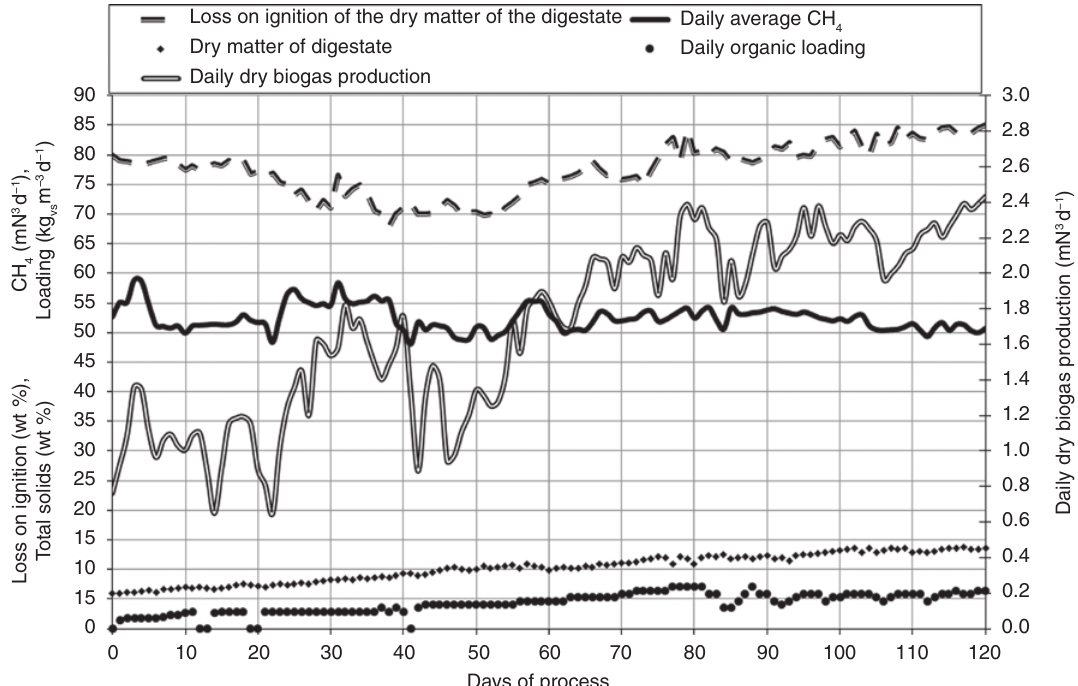
Figure 3: The progress of organic loading and biogas production.